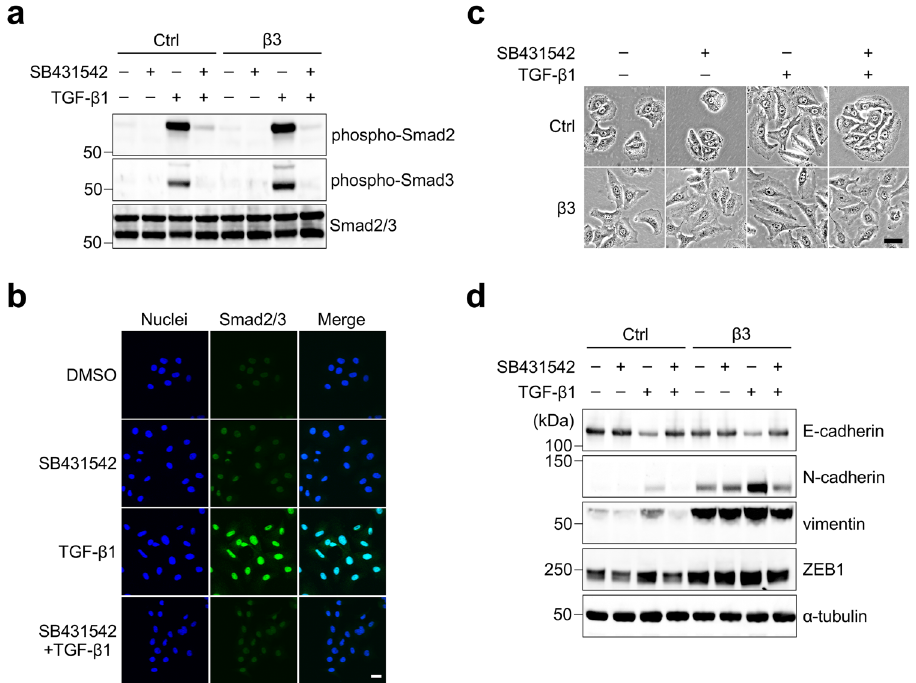
Fig. 7 Partial EMT induced by α v β 3 integrin is independent of TGF- β signaling. a Western blotting of phospho-Smad2, phospho-Smad3, and Smad2/3 in control and β 3-A549 cells pretreated with or without 5 µ M SB431542 for 20 min and then treated with 2 ng/ml TGF- β 1 for 30 min either separately or in combinations. b Anti-Smad2/3 immuno fl uorescence staining (green) of β 3-A549 cells treated with DMSO, 2 µ M SB431542, and 4 ng/ml TGF- β 1 for 2 days either separately or in combinations. Nuclear staining (blue) was used to detect nuclei and the co-localization of nuclei with Smad2/3 in the merged panel. Scale bar, 25 µ m. c Cell morphology of control and β 3-A549 cells pretreated with or without 5 µ M SB431542 for 20 min at room temperature and then treated with 5 ng/ml TGF- β 1 for 17 h either separately or in combinations. Scale bar, 40 µ m. d Western blotting of EMT markers in control and β 3- A549 cells pretreated with or without 5 µ M SB431542 for 20 min at room temperature and then treated with 5 ng/ml TGF- β 1 for 2 days either separately or in combinations. Unprocessed blot images in ( a and d ) are shown in Supplementary Fig.